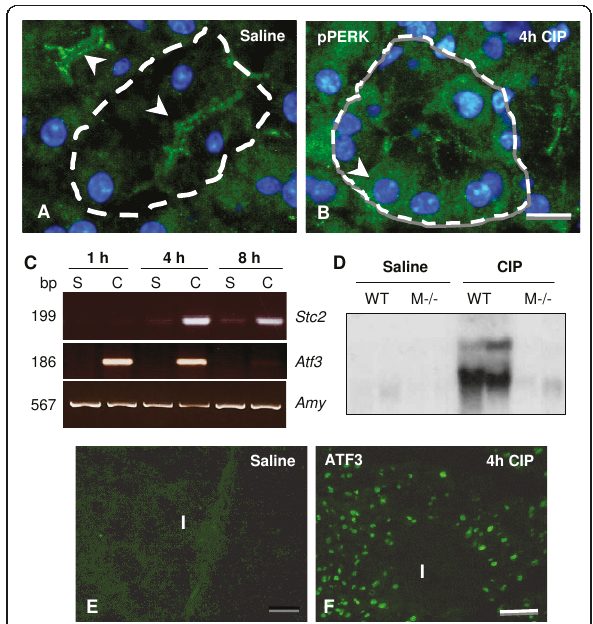
Figure 1 STC2 accumulation increases in pancreatic tissue following induction of pancreatic injury . (A, B) Immunofluorescence (IF) for pPERK (green) before ( A ) and 4 hours after ( B ) initiation of CIP. pPERK (arrowhead) localizes to the apical end of acinar cells under physiological conditions and more basally during CIP. Magnification bar = 13 μ M. DAPI was used to counter stain nuclei. (C) RT-PCR of whole pancreatic RNA extracts from saline (S) and cerulein (C) treated mice showed increased accumulation of Stc2 and Atf3 mRNA after initiation of CIP in pancreatic tissue. Amplification of Amylase ( Amy ) was used as a positive control for RT reactions. (D) Northern blot analysis revealed elevated Stc2 mRNA four hours after initial cerulein (CIP) or saline (S) injection. No increases in Stc2 were observed in Mist1 -/- (M-/-) pancreatic tissue under similar conditions. (E, F) IF for ATF3 expression revealed limited accumulation before CIP ( E ) and acinar- specific expression afterwards ( F ). Magnification bar = 63 μ M. I =